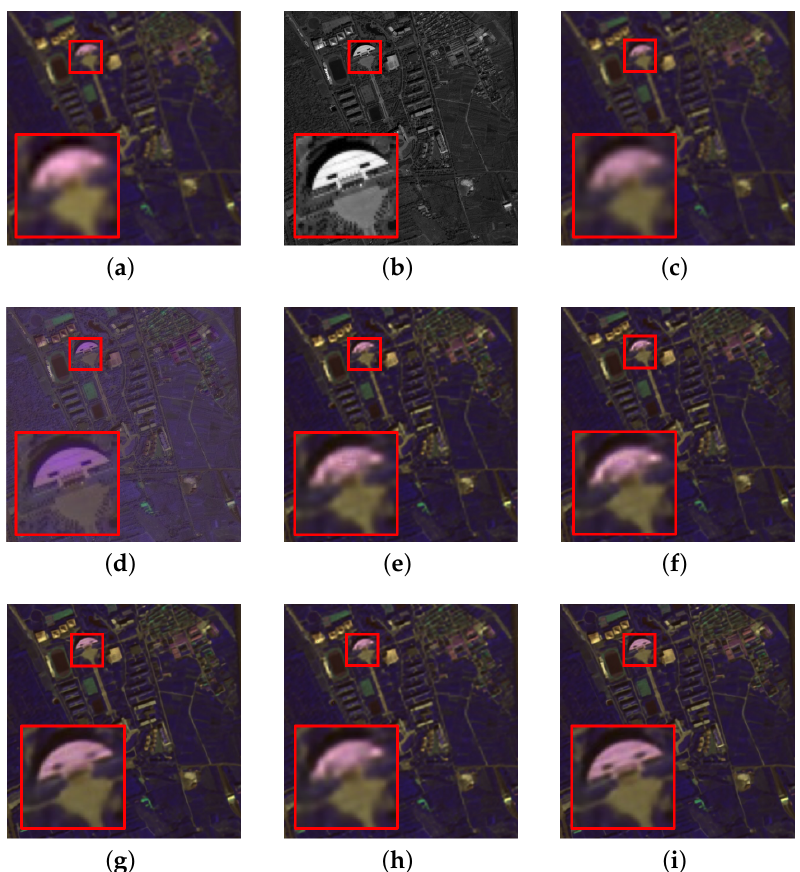
Figure 9. Comparison results obtained by different methods(real GF-2 image of Beijing, China). ( a ) LRMS image. ( b ) HRPAN image. ( c – i ) Pansharpening result of RSIFNN, Wavelet, PCA, SRCNN, TFCNN, PNN and the proposed